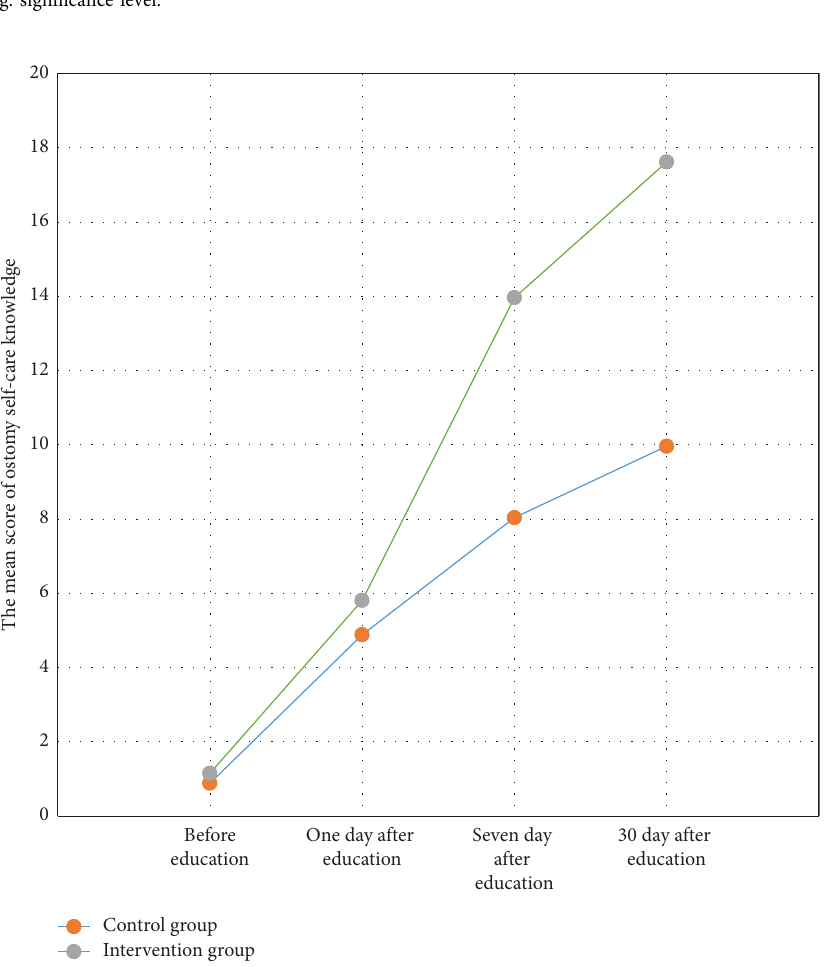
Figure 1: Te mean score of ostomy self-care knowledge throughout the timeline of the